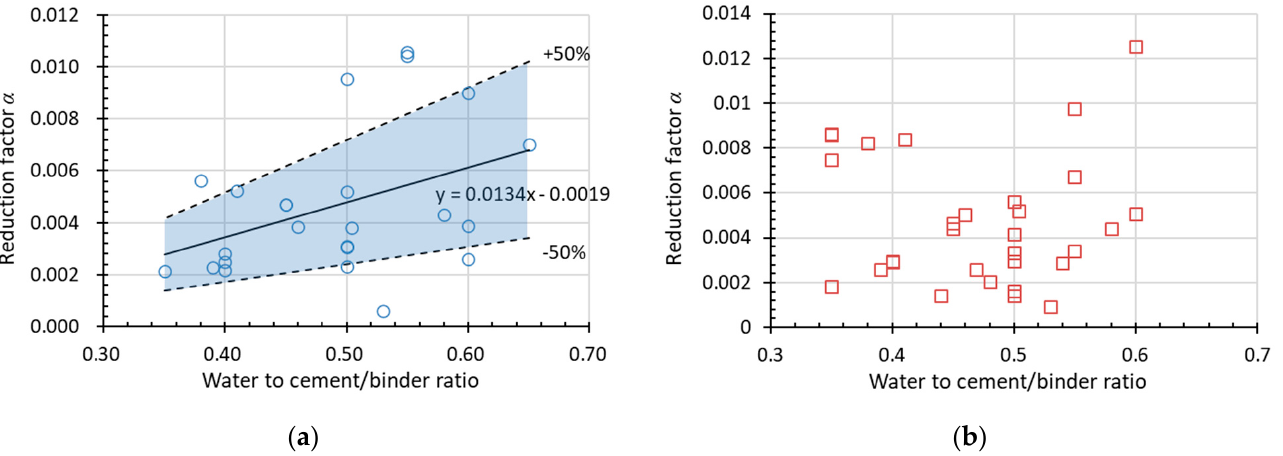
Figure 15. Factor α in the linear function in terms of w/c for ( a ) RDEM and ( b ) Rf c of non-air-entrained concrete.